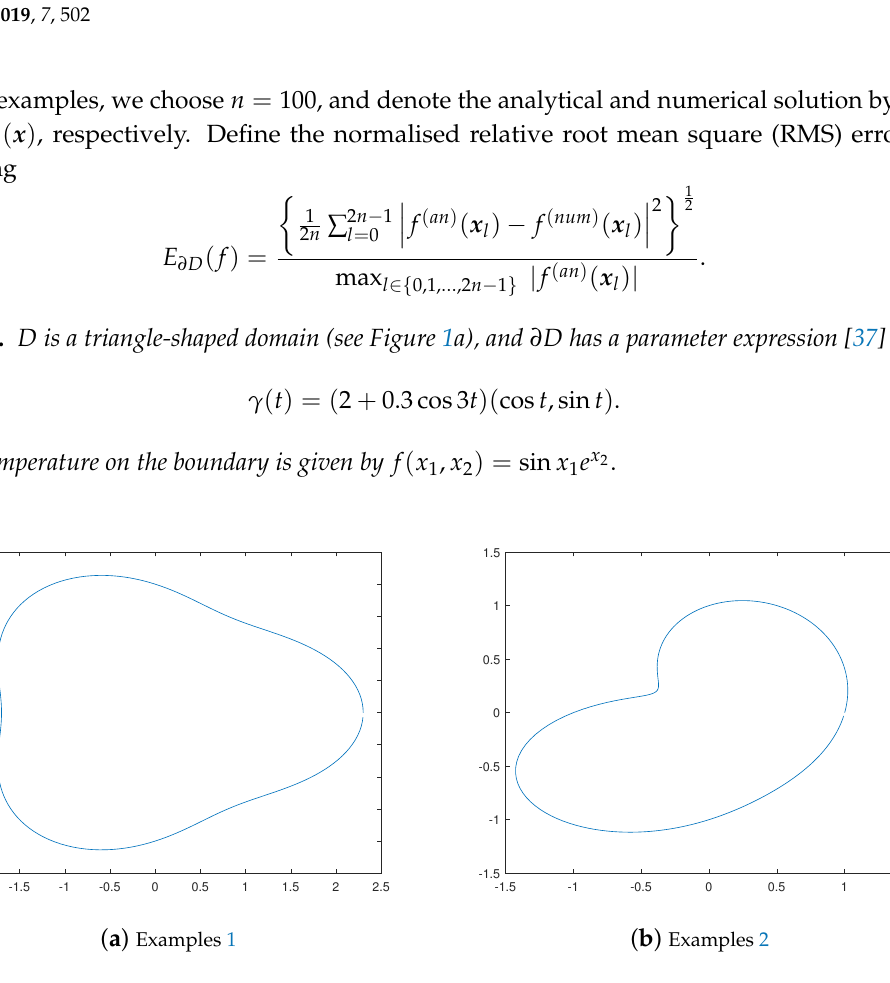
Figure 1. The shapes of